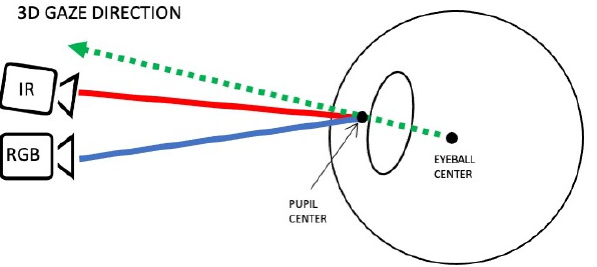
Figure 2. Illustration of 3D gaze direction mapping using a 3D model of the eye. The green ray is the 3D gaze